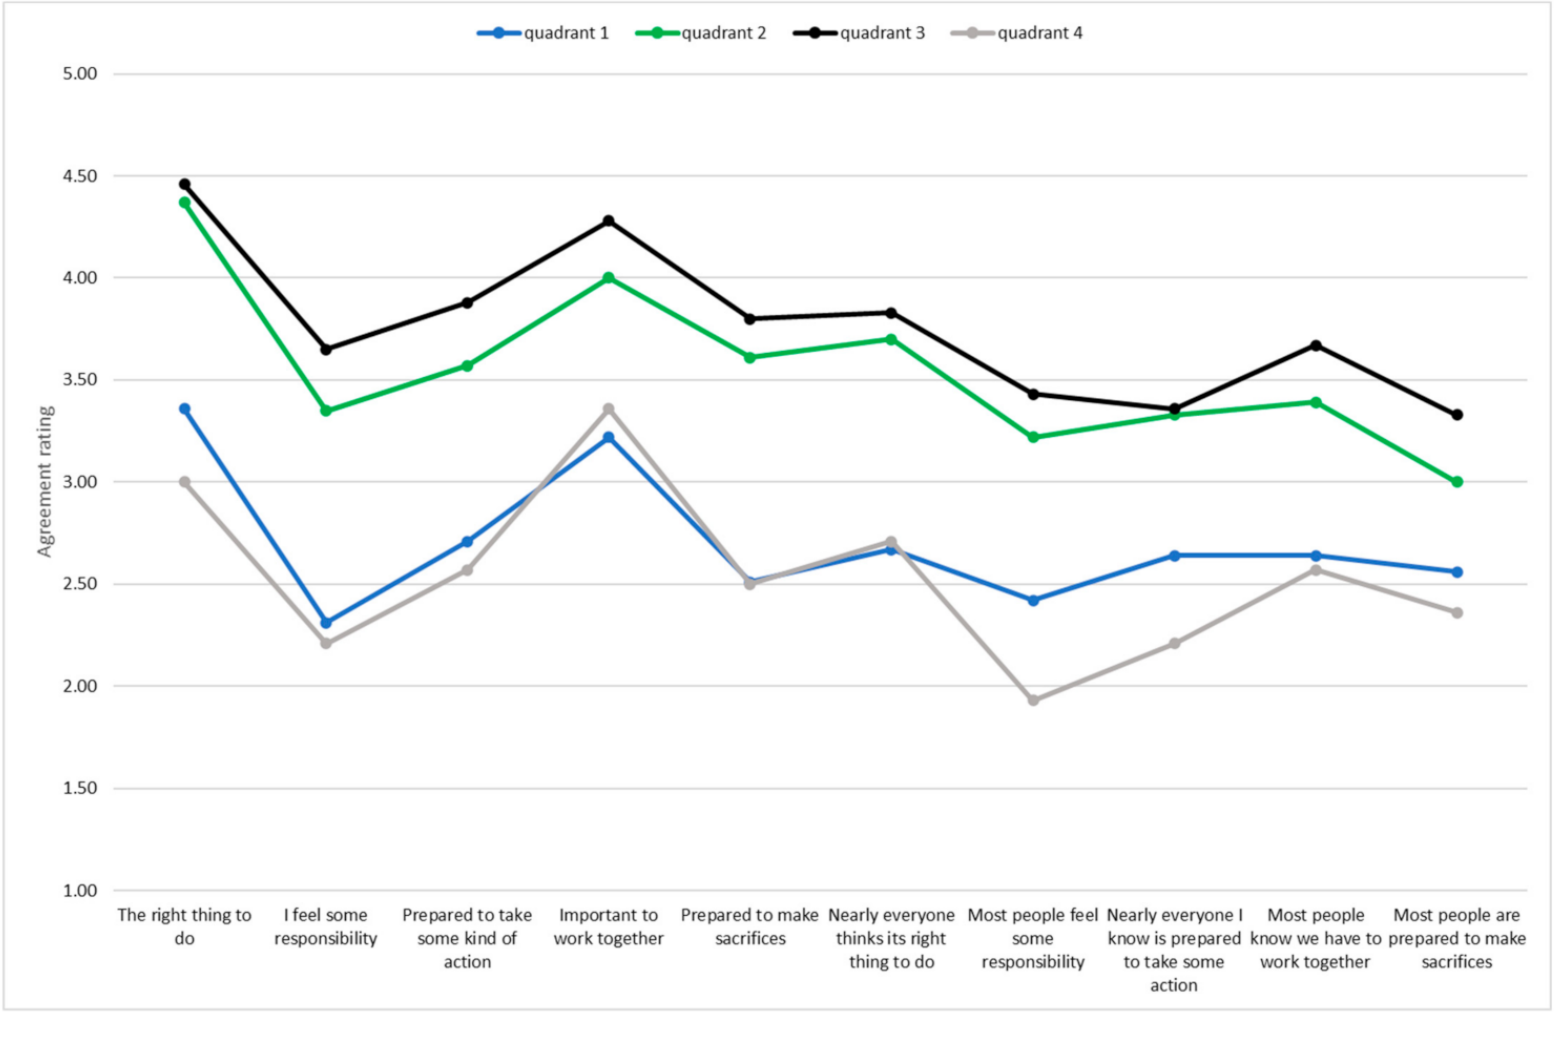
Figure 6. Respondents’ beliefs about responsibility for reducing possum